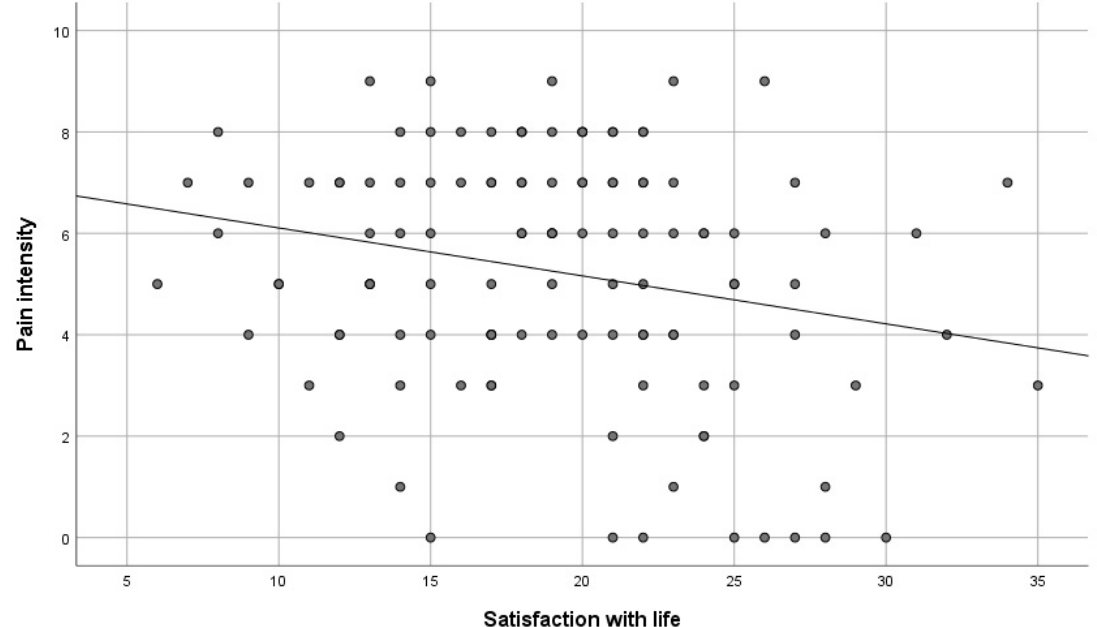
Figure 3. Pain intensity versus satisfaction with